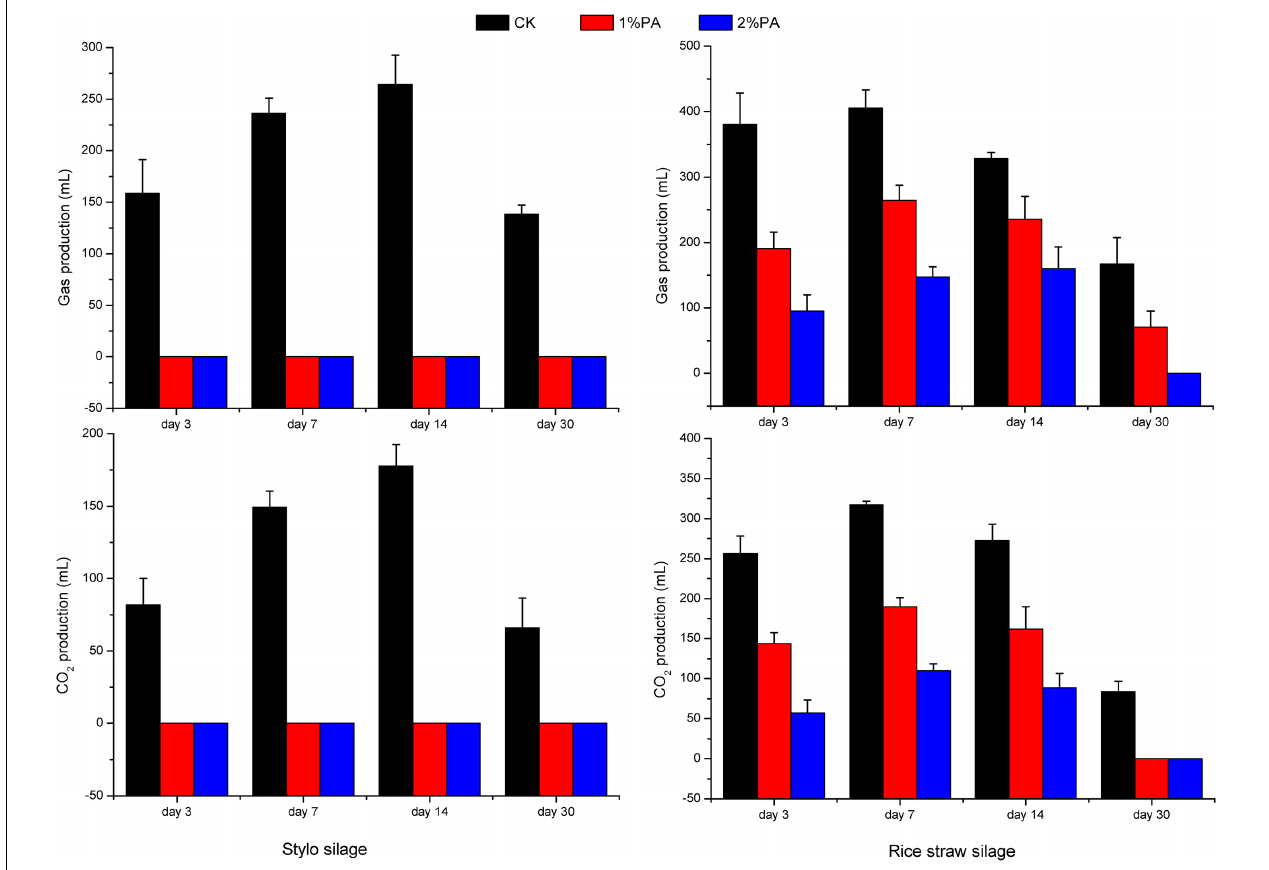
FIGURE 6 | Gas production and CO 2 production of stylo and rice straw silage after fermentation for 3, 7, 14, and 30 days with or without 1% or 2% pyroligneous